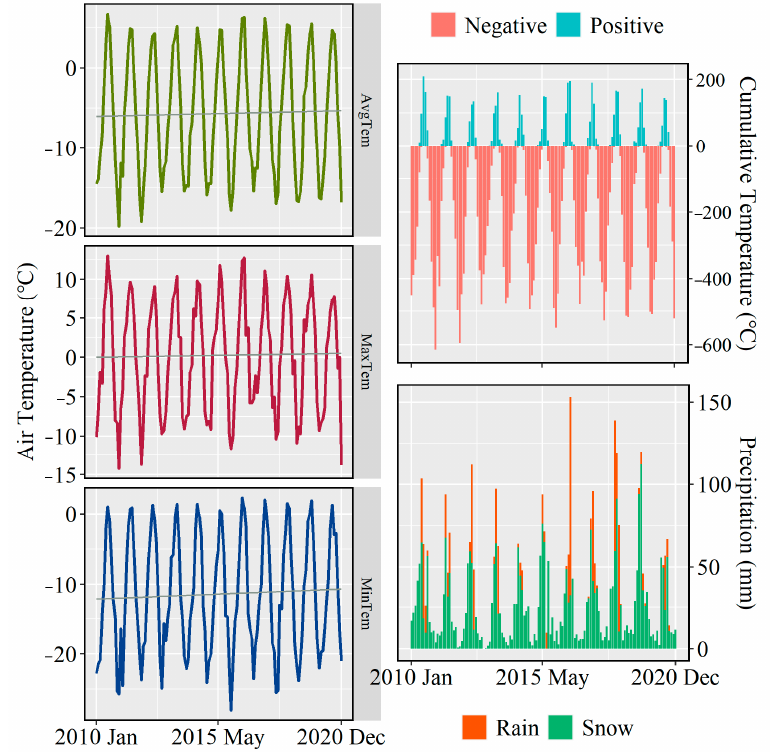
Figure 11. Features of temperature and precipitation of LHG12 at 4200 m a.s.l. in